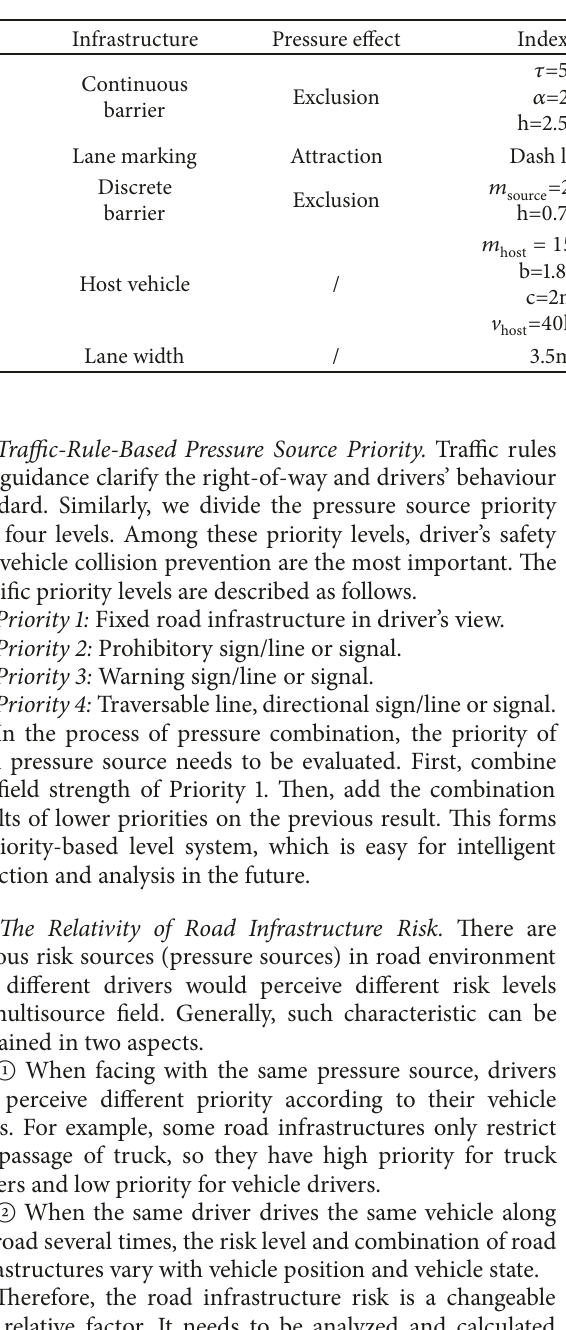
Table 6: Indexes of pressure